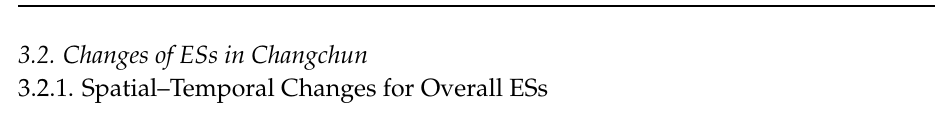
Figure 3. Spatial Distribution of ESs in 2000, 2015, and changes of Changchun.